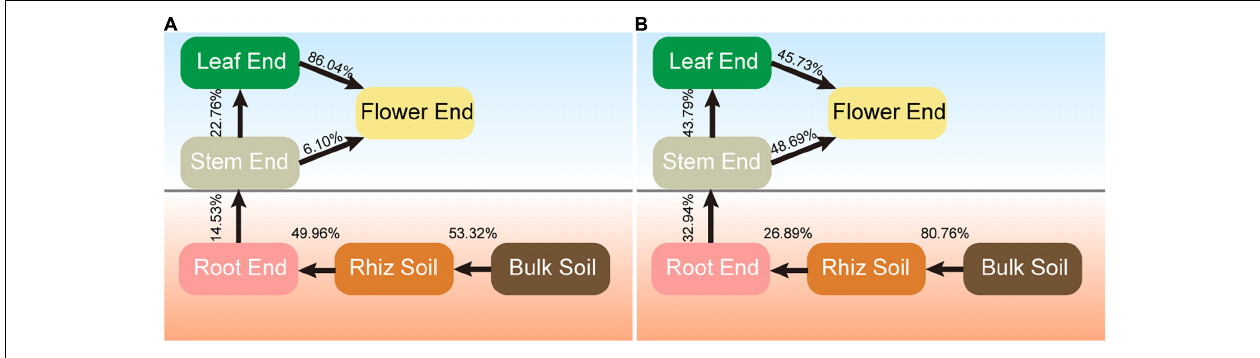
FIGURE 6 | Source model showing the potential sources of hemp associated microbial communities. (A) Bacteria. (B)